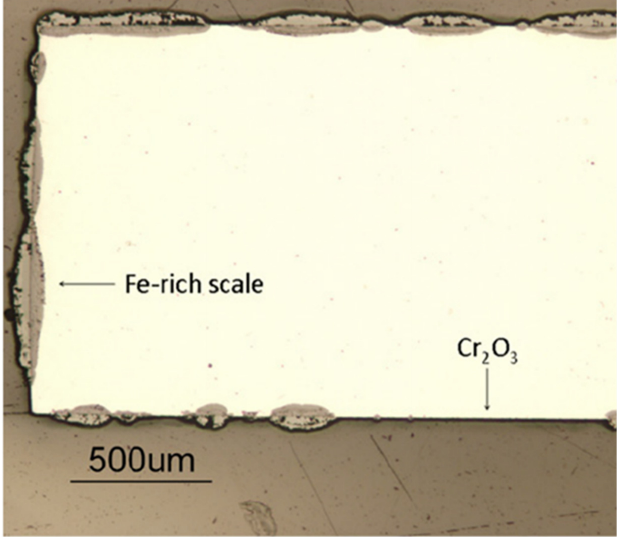
Figure 6. The cross-section of Fe20Cr after 120 h exposure to Ar-20%CO 2 at 650 °C/1 bar [33]. Re- produced with permission from